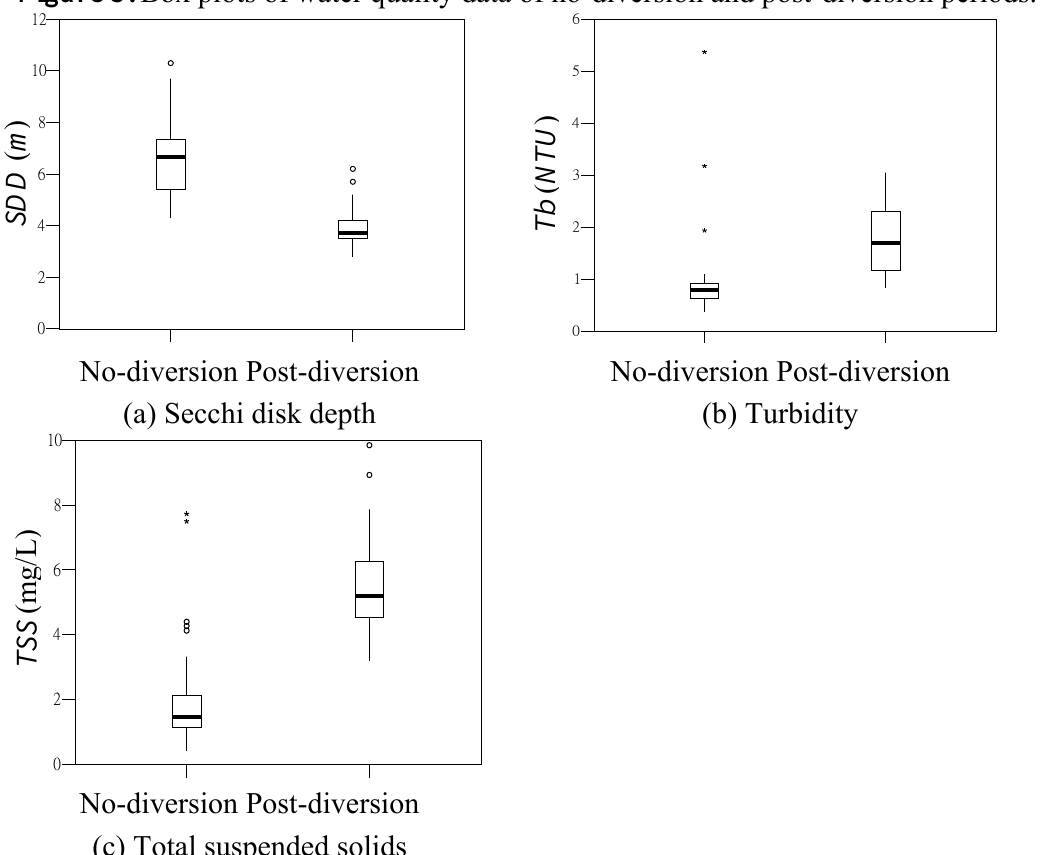
Figure 3. Box plots of water quality data of no-diversion and post-diversion periods. 12